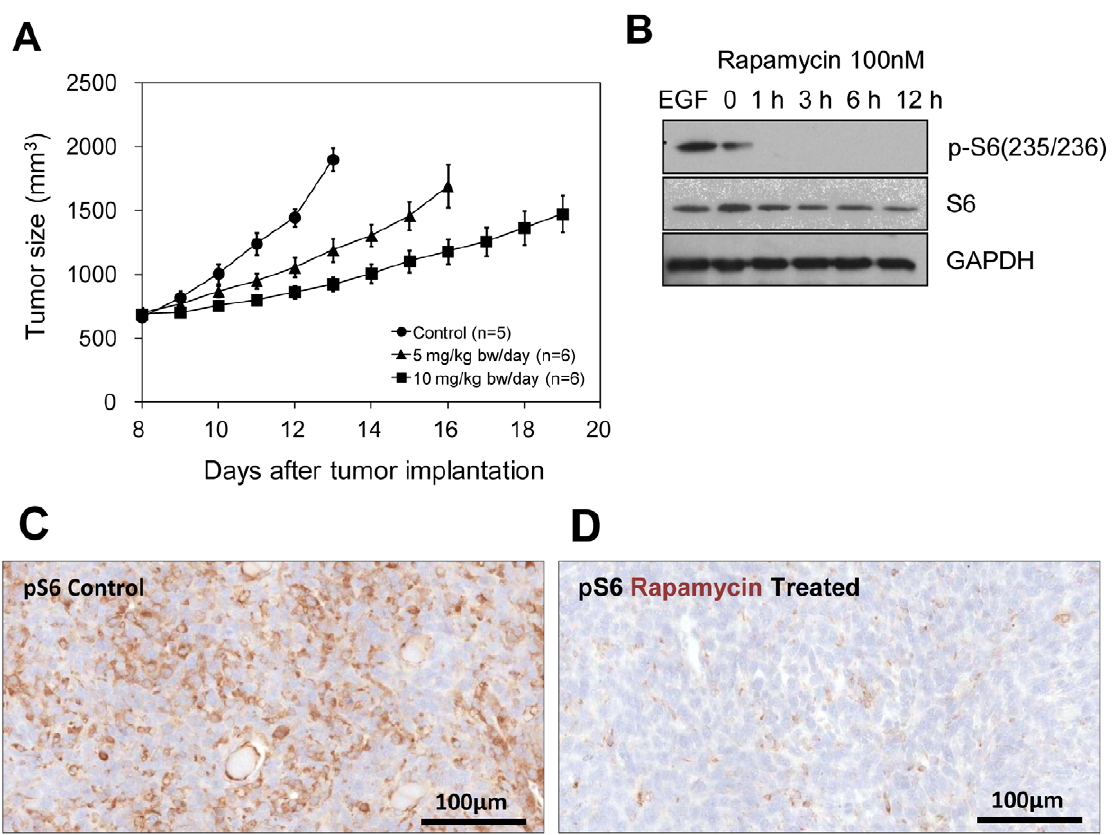
N Figure 1. Effect of rapamycin on SCC tumor growth and mTOR signaling pathway. (A) Tumor sizes of the SCC tumors in the mice leg ), 5 mg/kg bw/day ( m ), and 10 mg/kg bw/day ( & ) rapamycin. (B) Western blot analysis of S6 protein expression and treated with vehicle (control, the abundance of its phosphorylated form in SCC tumor cells treated with rapamycin (100 nM). (C, D) Immunostaining of pS6 in SCC xenograft of control and rapamycin treated (10 mg/kg bw/day, 2 days).